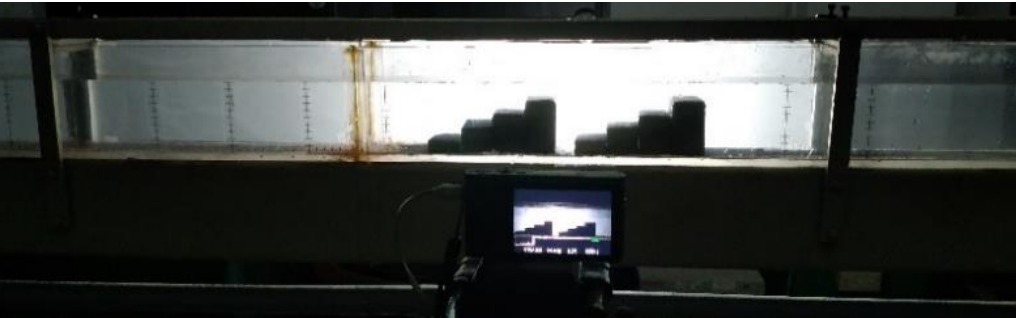
Figure 1. Schematic layout of wave flume and experimental setup.